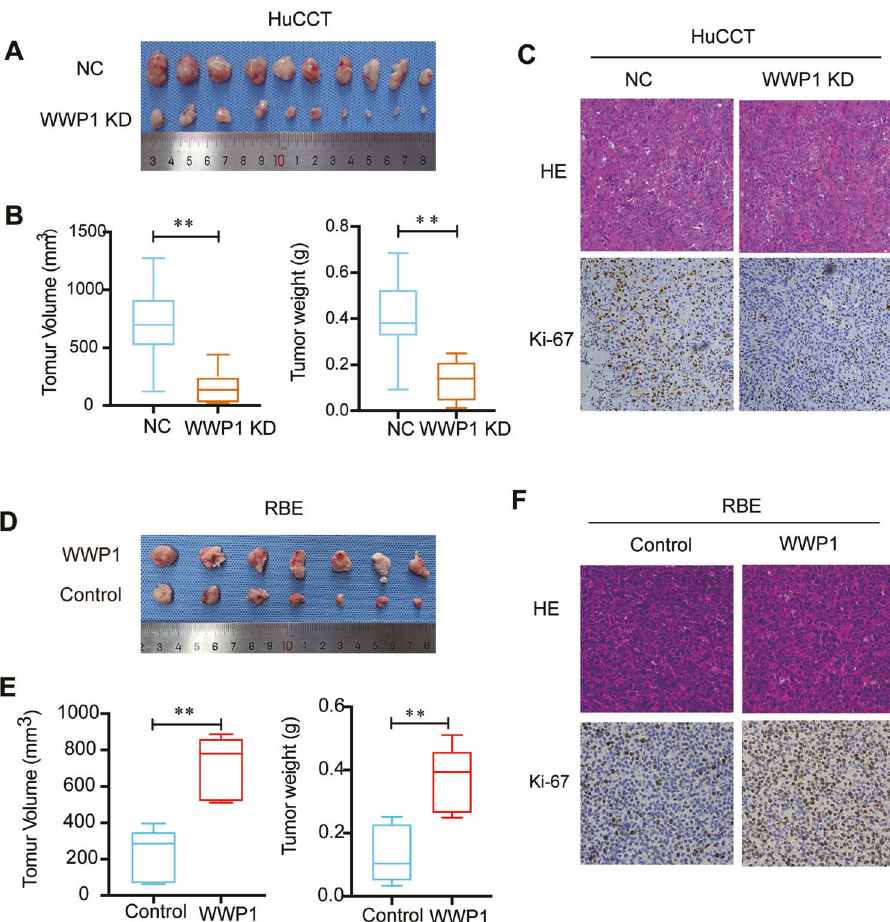
Fig. 4 WWP1 promoted the subcutaneous tumor growth of ICC cells in vivo. A – C Subcutaneous tumor models were applied to explore the impact of WWP1 silencing on proliferation in vivo. A The images of tumors were generated in nude mice using WWP1 silenced HuCCT1 cells, n = 10. B The volumes and weights of subcutaneous tumors between WWP1 silencing and negative control groups. C HE and Ki-67 IHC staining images of subcutaneous tumors. D – F Subcutaneous tumor models were performed to detect the in fl uence of WWP1 overexpression on proliferation in vivo. D The images of tumors were generated in nude mice using WWP1 overexpression RBE cells, n = 7. E The volumes and weights of subcutaneous tumors between WWP1 overexpression and vector groups. F HE and Ki-67 IHC staining images of subcutaneous tumors. ** P <